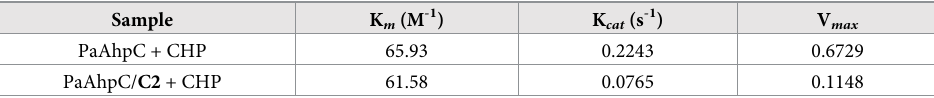
Table 4. Enzymatic parameters determined to cumene hydroperoxide (CHP) to PaAhpC pretreated without treatment or pre-treated with compound C2.